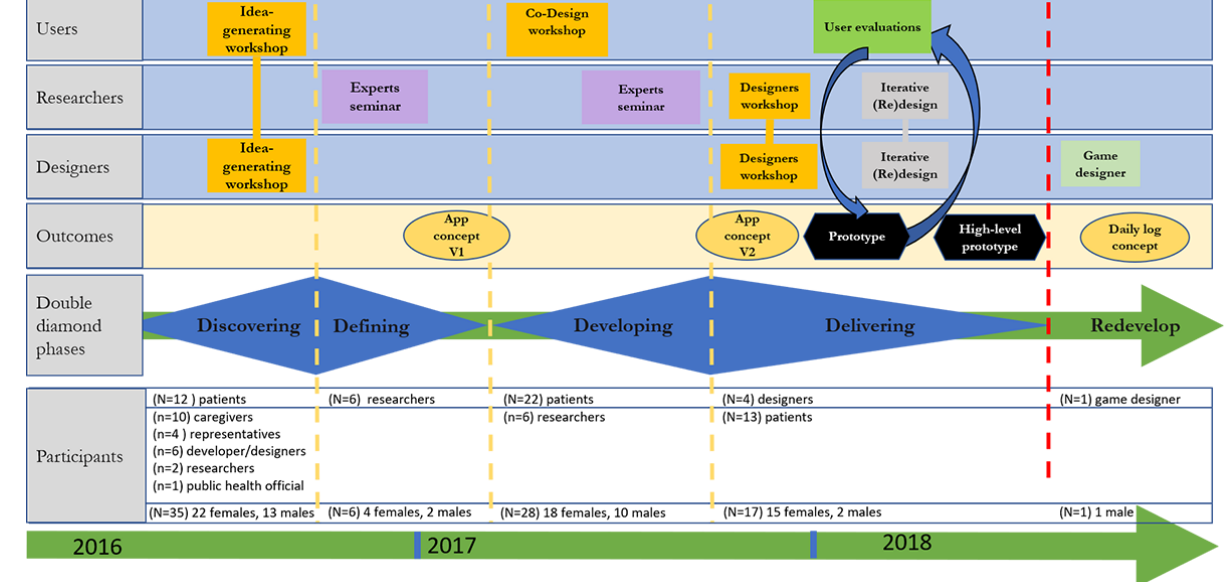
Figure 1. The project’s phases, activities, and